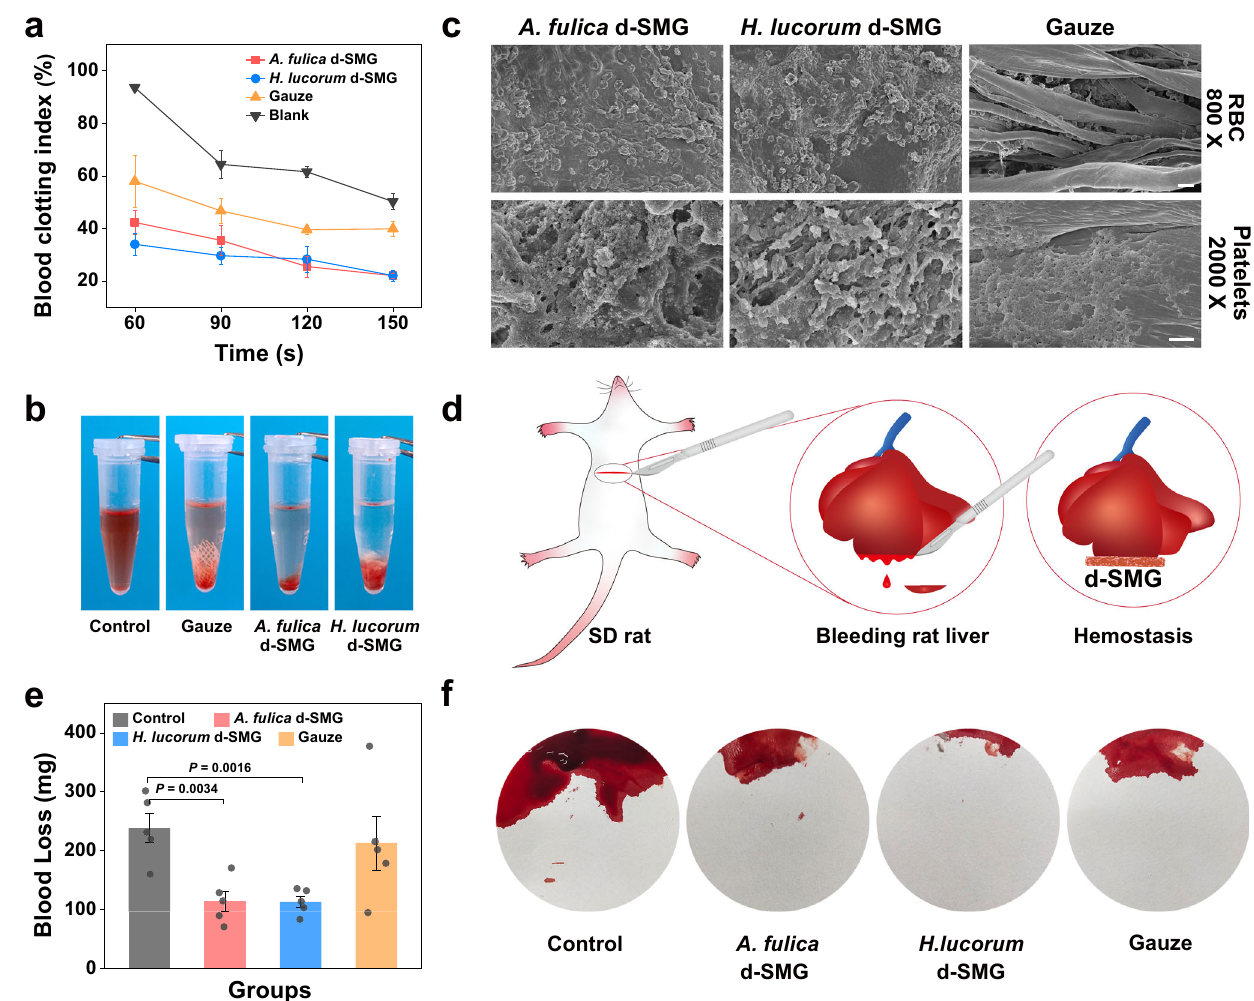
Fig. 4 | Hemostatic properties of d-SMGs. a Effect of d-SMGs on the dynamic blood-clotting index ( n =3 independent experiments in blank group; n =5 biolo- gically independent samples in A. fulica d-SMG, H. lucorum d-SMG and Gauze). b Photographsofbloodclottingat150s. c Scanningelectronmicrographsofwhole bloodandplateletscontactedwithd-SMG(onebiologicallyindependentsamplein each group). d Schematic for inducing bleeding on rat liver and stopping bleeding